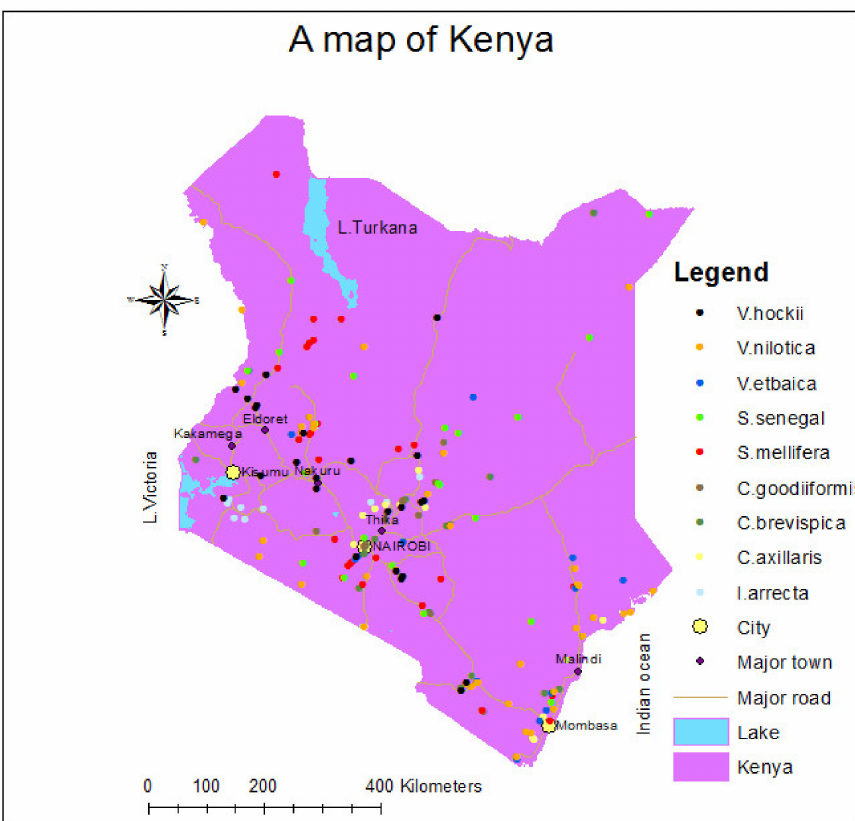
Figure 1. Map of Kenya. Adapted from maps downloaded from The IGAD Climate Prediction and Applications Centre (ICPAC)